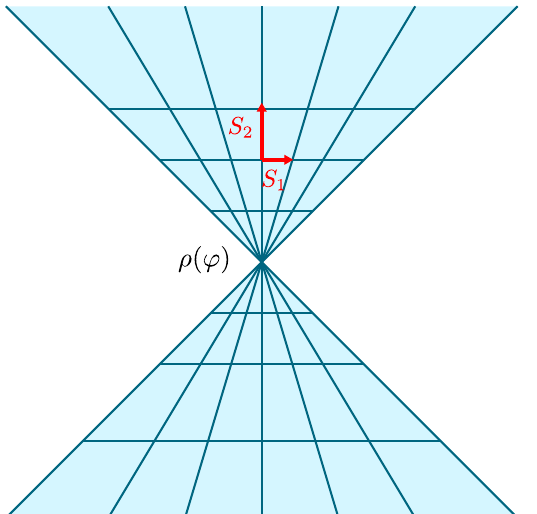
FIG. 12. The lines denote the Cartesian grid of θ 1 and θ 2 . The distortion of the grid represents the geometry of ρ ð θ 1 ; θ 2 Þ . For example, the distance from one grid point ð θ 1 ; θ 2 Þ to a neighbor- ing ð θ 1 þ Δ ; θ 2 Þ in the figure represents the distance between ρ ð θ θ ρ ð θ Δ ; θ 1 ; 2 Þ and 1 þ 2 Þ . S 1 and S 2 are tangent vectors, and K ¼ h S; S i is a metric that governs the infinitesimal distance between two neighboring ρ ’ s. At the singular point ρ ð φ Þ , K 11 ¼ 0 , the tangent space becomes a line in the S 2 direction, which forbids the existence of influence operators for certain ∂ β